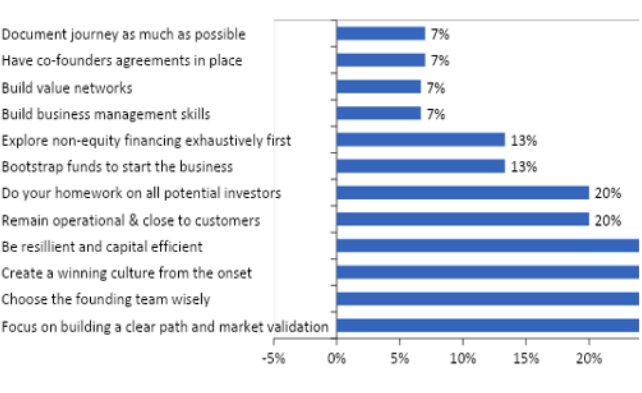
Figure 15: Advice to new Startup Founders